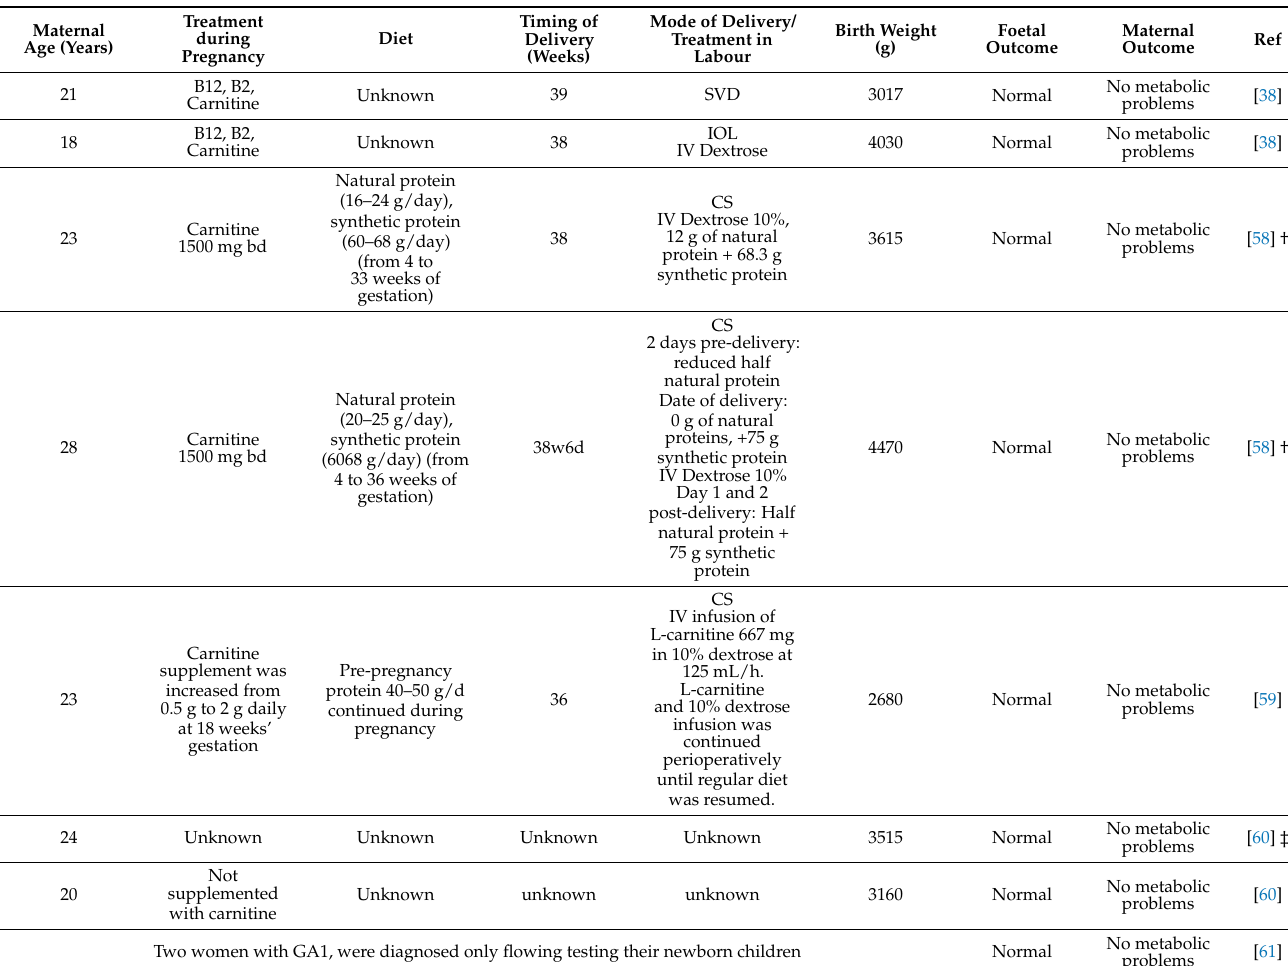
Table 6. Published literature on pregnancies in